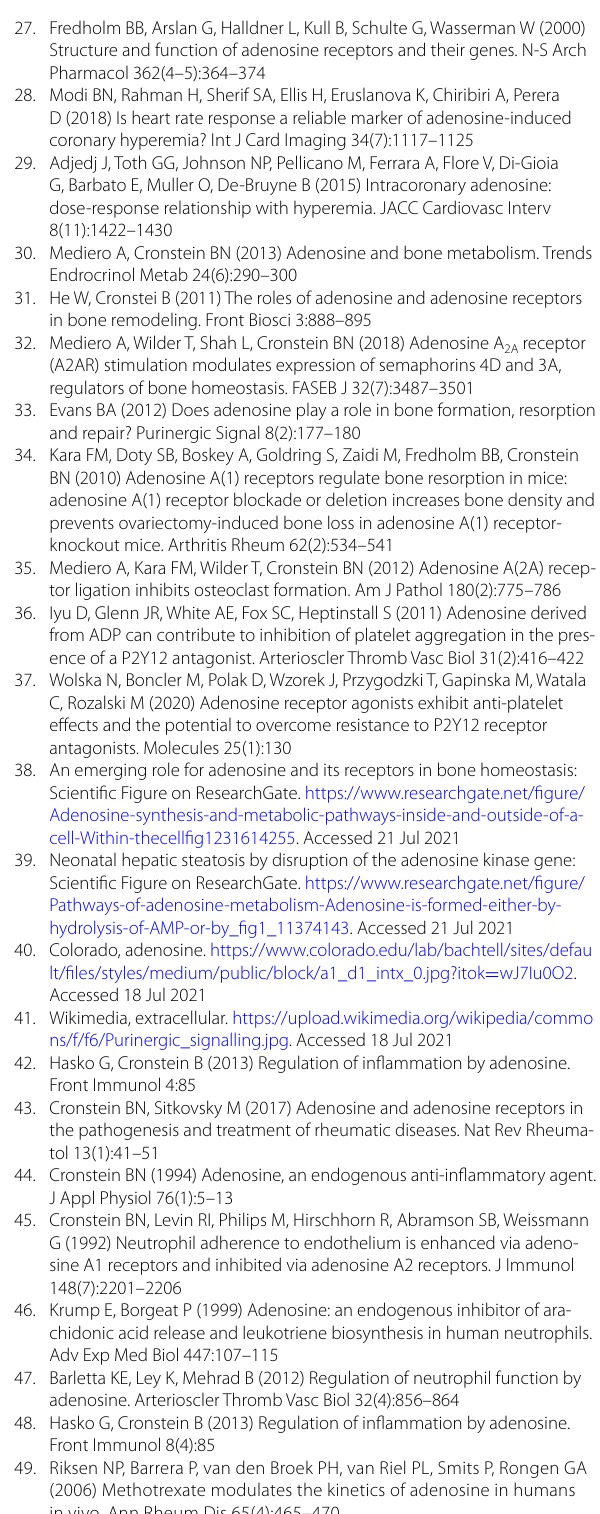
Scientific Figure on ResearchGate. https:// www. resea rchga te. net/ figure/ Pathw ays- of- adeno sine- metab olism- Adeno sine- is- formed- either-